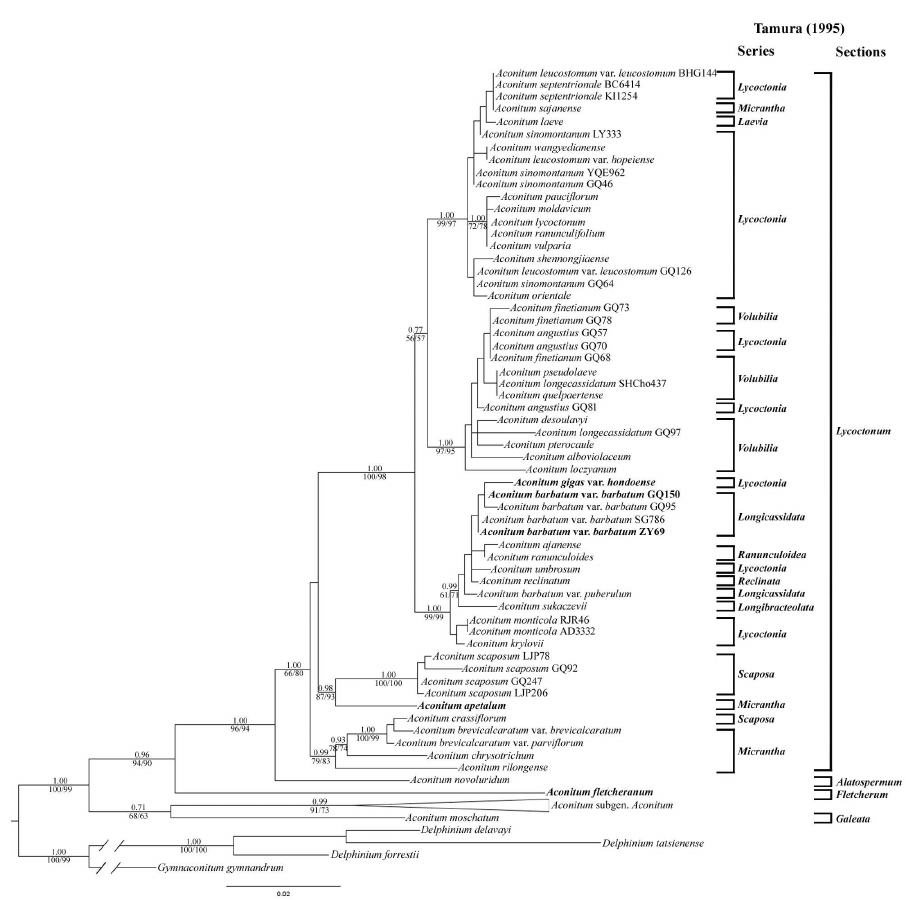
Fig 2. Phylogenetic relationships in Aconitum obtained from an ML analysis of the combined nrDNA dataset. Numbers above branches are posterior probabilities; numbers belowbranchesare bootstrap values for maximum parsimony/maximum likelihoodanalyses. Tamura’s (1995) classification of subgen. Lycoctonum are shown on the right. Accessions with a different placementin the cpDNA tree are indicatedin bold. The clade of subgen. Aconitum has been collapsedfor saving space (see S2 Fig for the complete